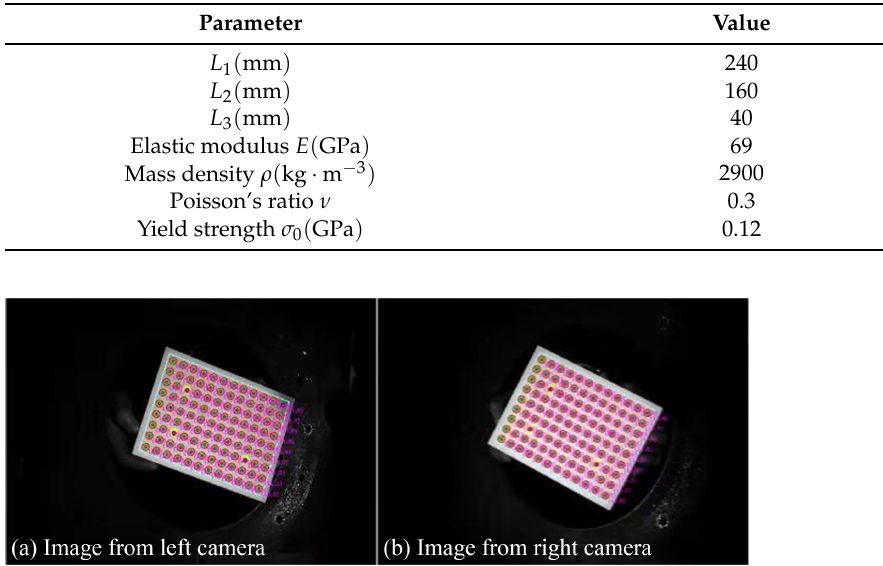
Table 1. Geometric and material parameters of thin-walled metal ellipsoidal shells.